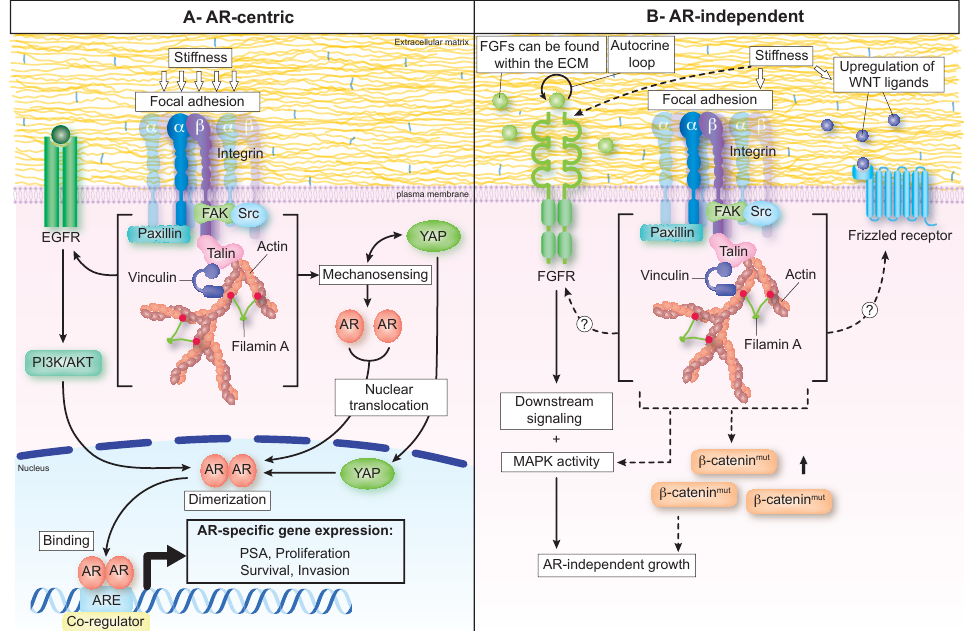
Figure 2. Signaling pathways activated by ECM stiffness and linked to castration resistance mecha- nisms in prostate cancer. ( A ) AR-centric mechanisms. Matrix stiffness, through an excessive ECM protein deposition and their crosslink, is sensed by focal adhesions, which can in turn activate EGFR or promote YAP nuclear translocation, a mediator of the HIPPO pathway. Activated PI3K/AKT down- stream of EGFR could then promote AR translocation to the nucleus, followed by its dimerization, allowing it to bind to specific regions in the DNA to trigger pro-tumorigenic cellular responses (pro- liferation, invasion, and survival). Nuclear YAP could also bind AR and enhance its transcriptional activity. ( B ) AR-independent mechanisms. Matrix stiffness sensed by focal adhesions can potentially activate FGFR or modulate the WNT pathway to drive AR-independent growth of prostate cancer. FGFs that are stored in the ECM can serve as ligands of the FGF signaling axis, and stiffness-activated FGFR will turn on downstream signaling (MAPK) to drive prostate cancer progression. Alternatively, the WNT pathway’s activation by increased stiffness can result from upregulation of the WNT ligands or increase sensitivity of the Frizzled receptor to its ligands. Increase in mutant β -catenin levels could further facilitate the crosstalk between focal adhesions and the WNT pathway. Altogether, these mechanisms could contribute to ECM stiffness-driven prostate cancer disease progression. AR: androgen receptor; ARE: androgen response element; EGFR: epidermal growth factor receptor; FAK: focal adhesion kinase; FGFR: fibroblast growth factor receptor; FGFs: fibroblast growth factors; PSA: prostate-specific antigen; YAP: Yes-associated